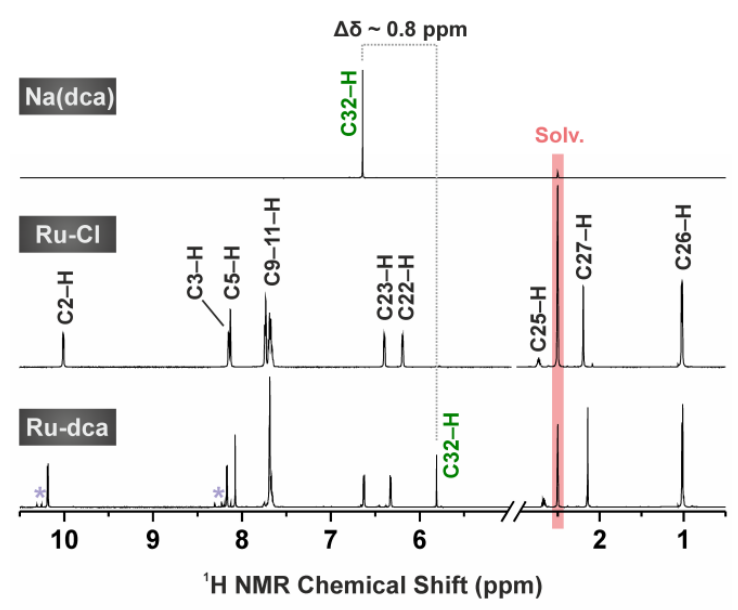
Figure 3. 1 H NMR spectra (DMSO- d 6 solutions) of Na(dca) (top), complexes Ru-Cl (middle) and Ru-dca (bottom) given together with the assignment of the detected signals (see Figure 1 for the atom numbering scheme). Note: the impurity visible in the 1 H NMR spectrum of complex Ru-dca can be assigned to the [Ru( η 6 - p cym)(bphen)(OH)] + species (violet